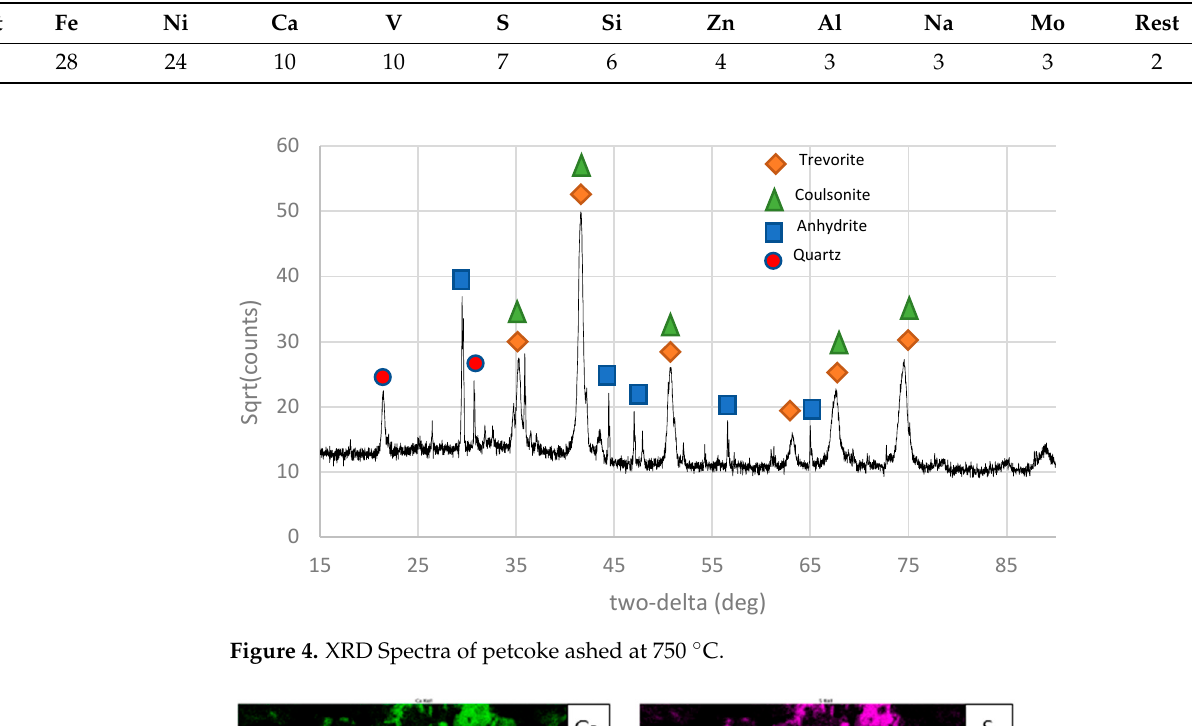
Table 2. Composition of the petcoke under study.